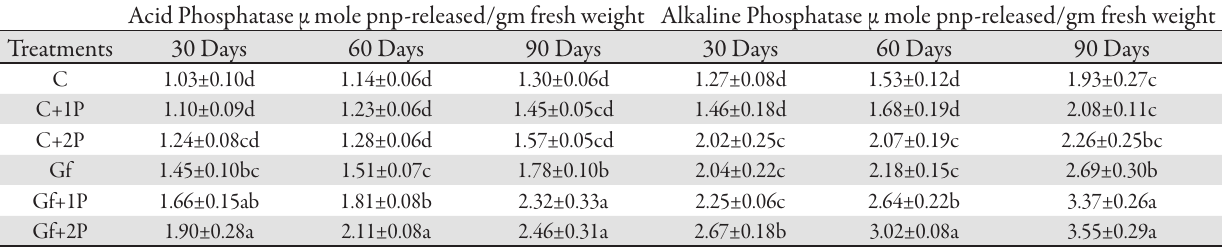
Tab. 5. Acid and alkaline phosphatase in Arachis hypogaea L. after 30, 60 and 90 days of AM